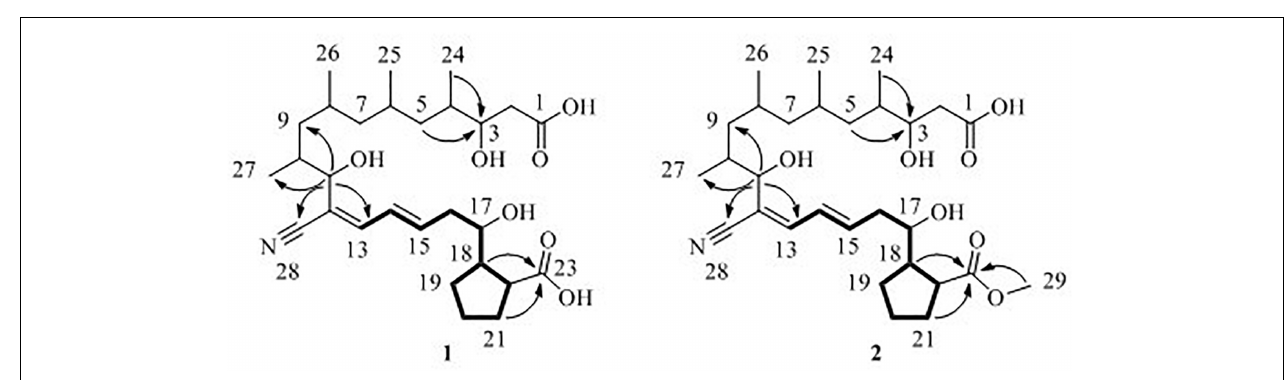
FIGURE 4 | 1 H– 1 H COSY ( — ), key HMBC ( (cid:121) ) correlations of compounds 1 and 2 .